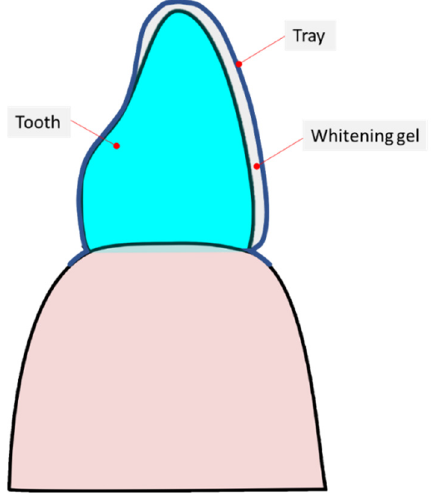
Figure 3. Schematic of the tray when it is worn and is on the